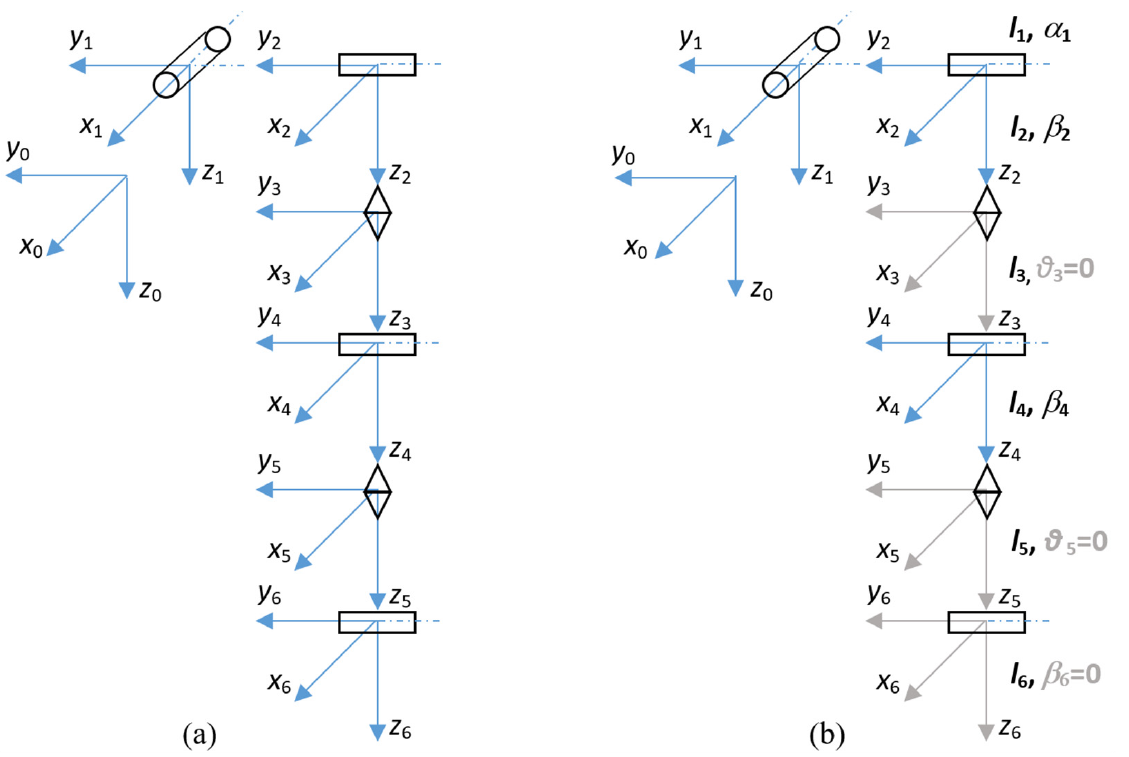
Figure 2. Structure of the exoskeleton: the full configuration on the left ( a ) and the structure of the constructed prototype on the right ( b ). The components highlighted in gray in Figure 2 were not installed in the prototype: